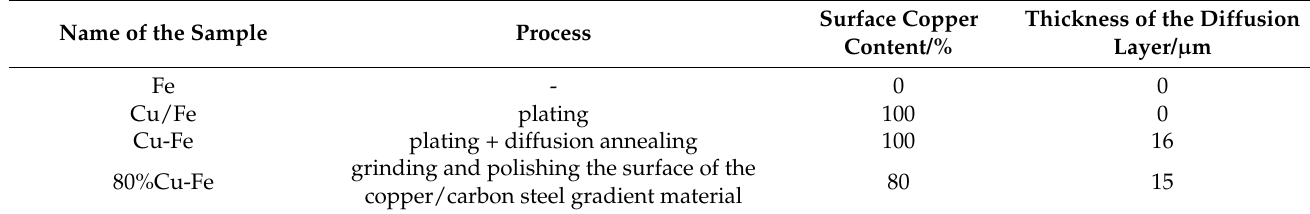
Table 1. Process and characteristic of different